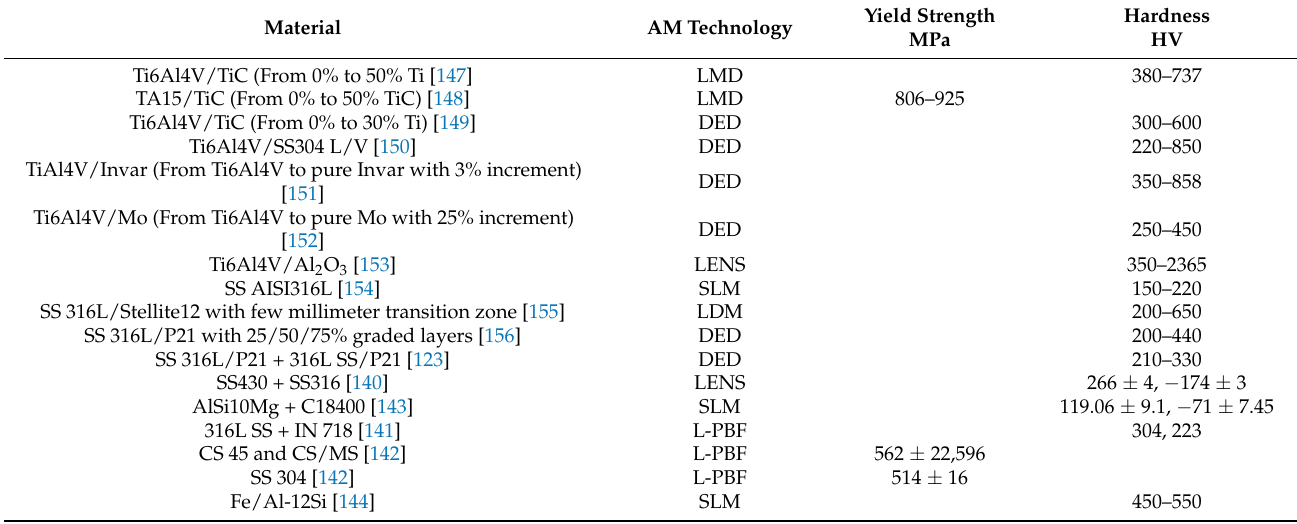
Table 4. Materials and their mechanical properties used in